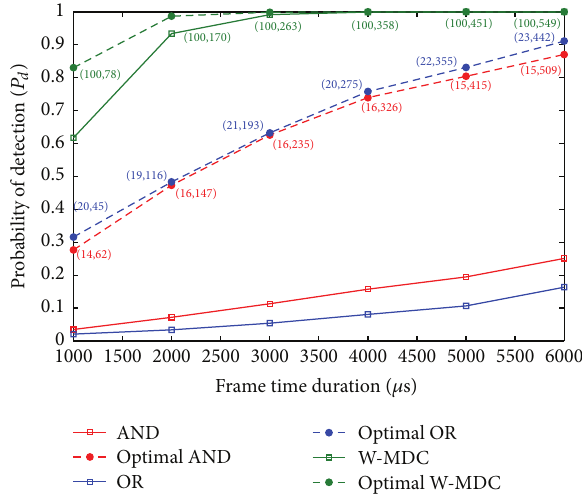
Figure 5: The probability of detection ( 𝑃 𝑑 ) versus network size ( 𝑀 ) for AND, OR, and weighted MDC fusion scheme; network and targeted normalized throughput = 0.9 and 𝜏 max = 100 𝜇 s with ( 𝑘 opt , 𝜏 opt ) values are shown in the data tips.